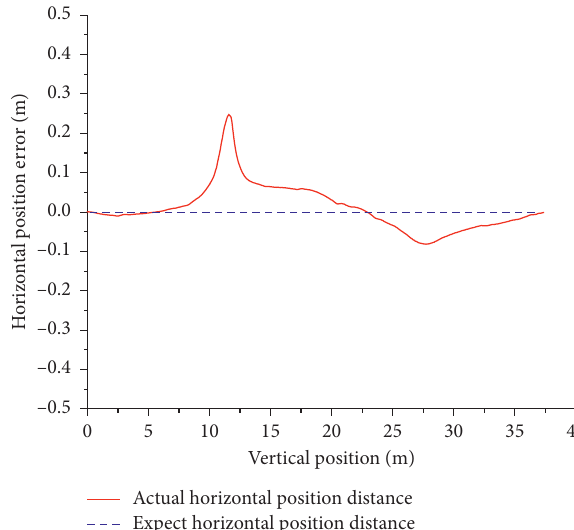
Figure 26: Comparison of horizontal tracking.